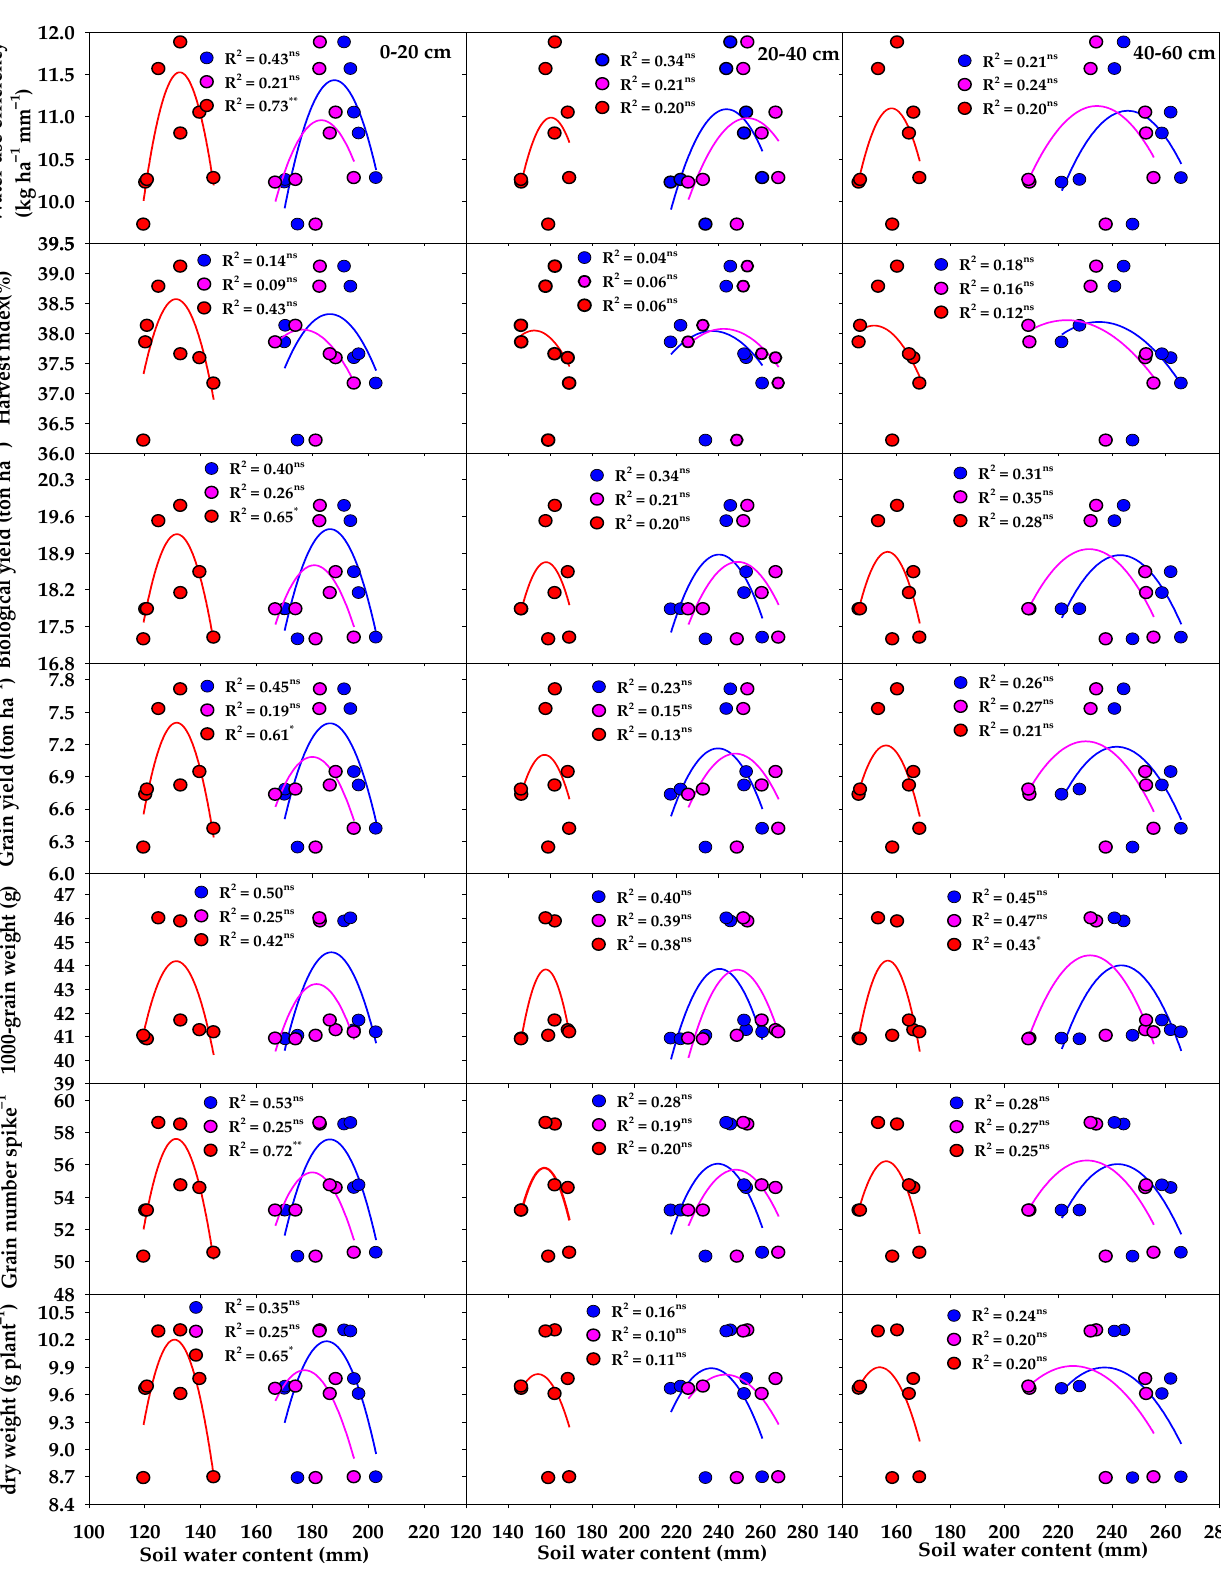
100 120 140 160 180 200 220 Soil water content (mm) Figure 9. Functional relationship between different plant parameters and the soil water content measured before irrigation at 56 (circle green), 87 (circle pink), and 108 (circle red) days after planting at deferent soil depth under full irrigation rate (1.00 ET). *, and ** indicate significant at p < 0.05 and 0.01, respectively; ns indicates not significant.